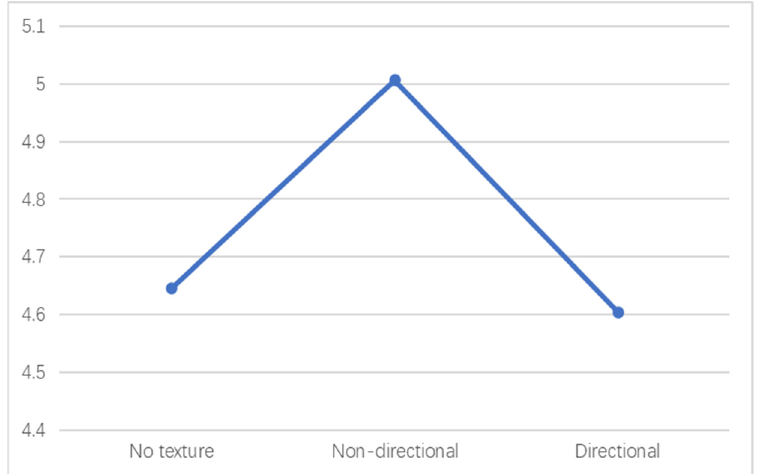
Figure 6. Mean value of texture classification.